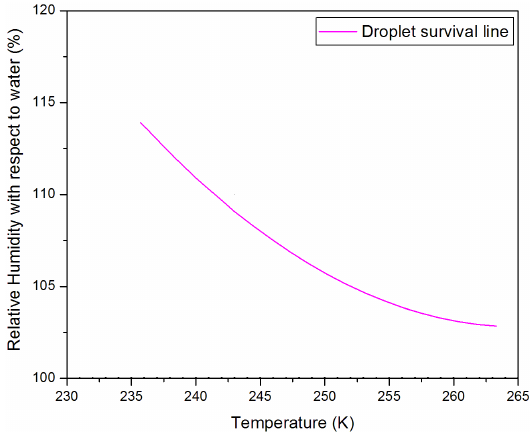
Fig. 3. Aerosol penetrating fraction of the impactor used. Note the sharp cut-off at 1µm aerodynamic diameter. The magenta curve is the sigmoid fit of the blue data points. Green error bars represent the standard deviation of the